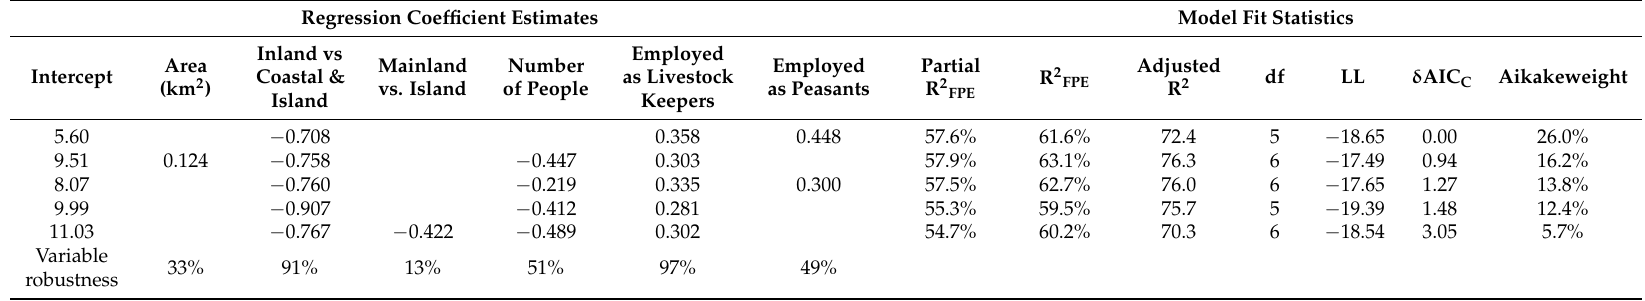
Table 2. Regression coefficients and model fit statistics for models predicting dog populations in Tanzania. Statistics are shown for all models with δ AIC C < 4, ranked in order of decreasing fit as gauged by δ AIC C . We report the predictor variable regression coefficient estimates, model fit statistics including the partial R 2 FPE , the R 2 FPE, , adjusted R 2 , the degrees of freedom (df), the log-likelihood (LL), delta AIC ( δ AIC C ), and akaike weights. We also report the importance of each predictor variable (variable